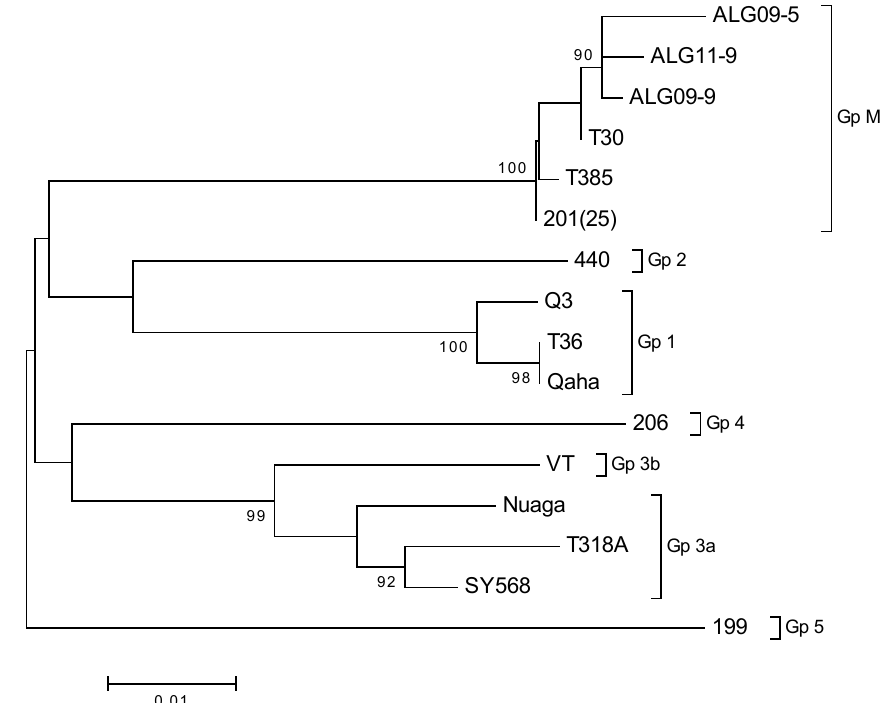
Figure 2. Phylogenetic tree of the CP gene sequences from CTV isolates ALG09 and ALG11. The tree was constructed from the matrix of pairwise distances (Kimura 2 parameters) by the neighbour-joining method. Numbers close to the nodes represent the bootstrap values obtained from 1,000